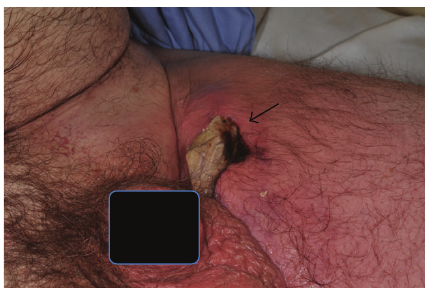
Figure 1: Photograph demonstrating 4 × 10 am elliptical area of necrotic tissue (arrow).